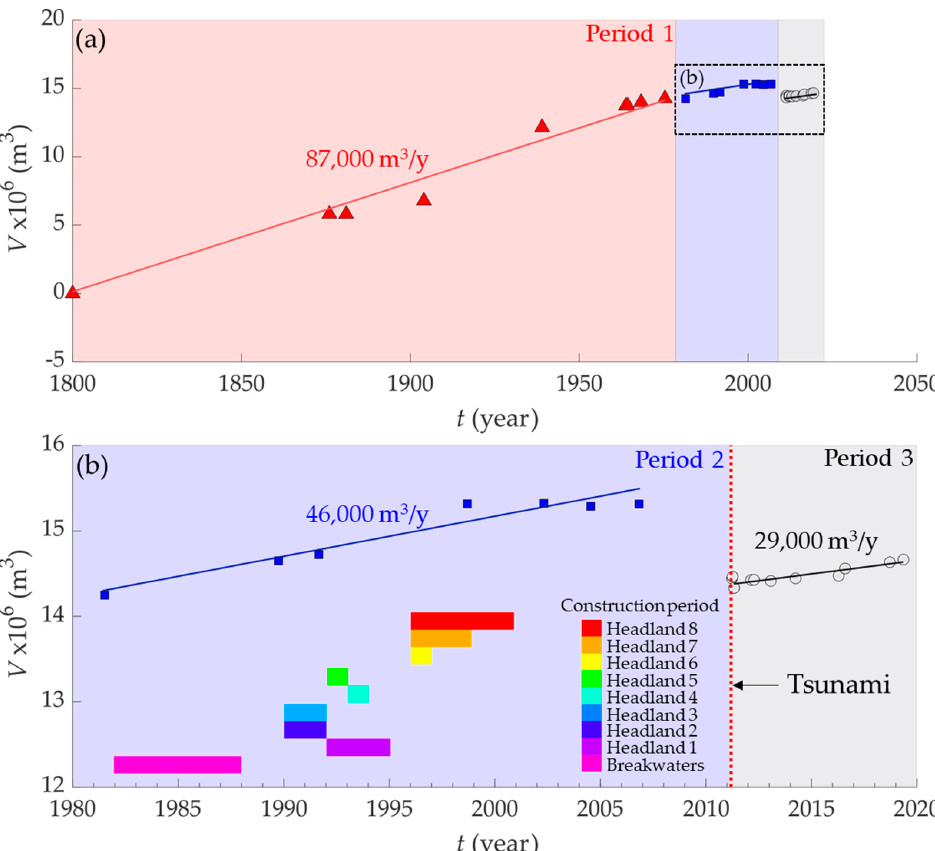
Figure 11. Sediment volumetric change and annual net sediment input to the Nobiru Coast. ( a ) Period 1. ( b ) Period 2 and Period 3.